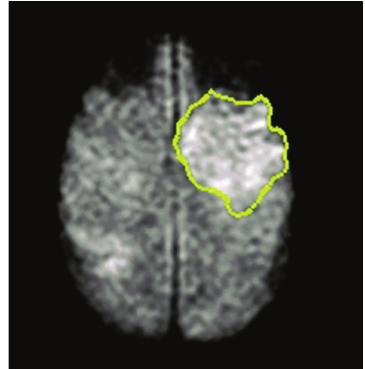
Figure 3: 48h reperfusion T2WI shows high-signal infarction smaller than lesion on DWI.